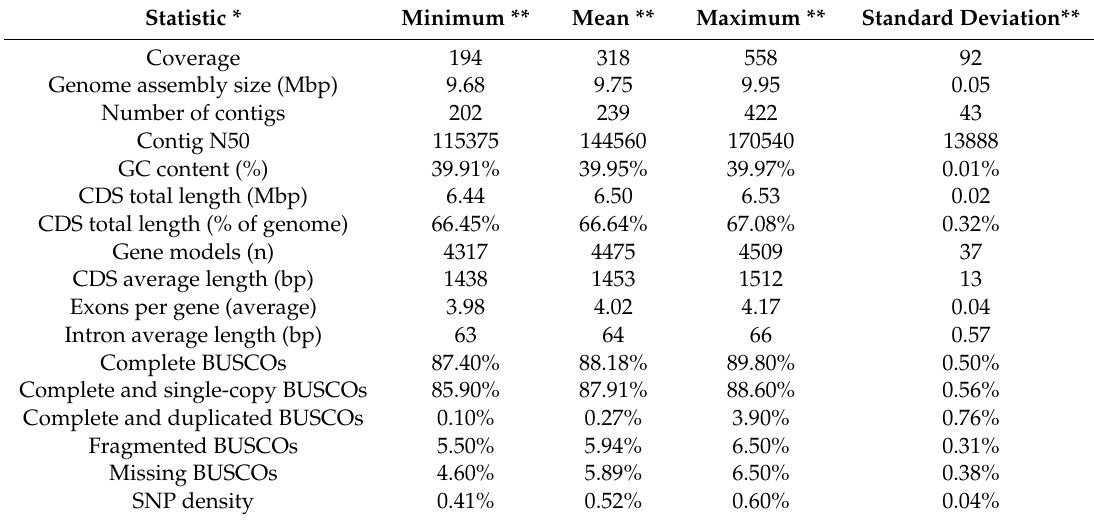
Table 2. Statistics for the sequenced Wallemia mellicola